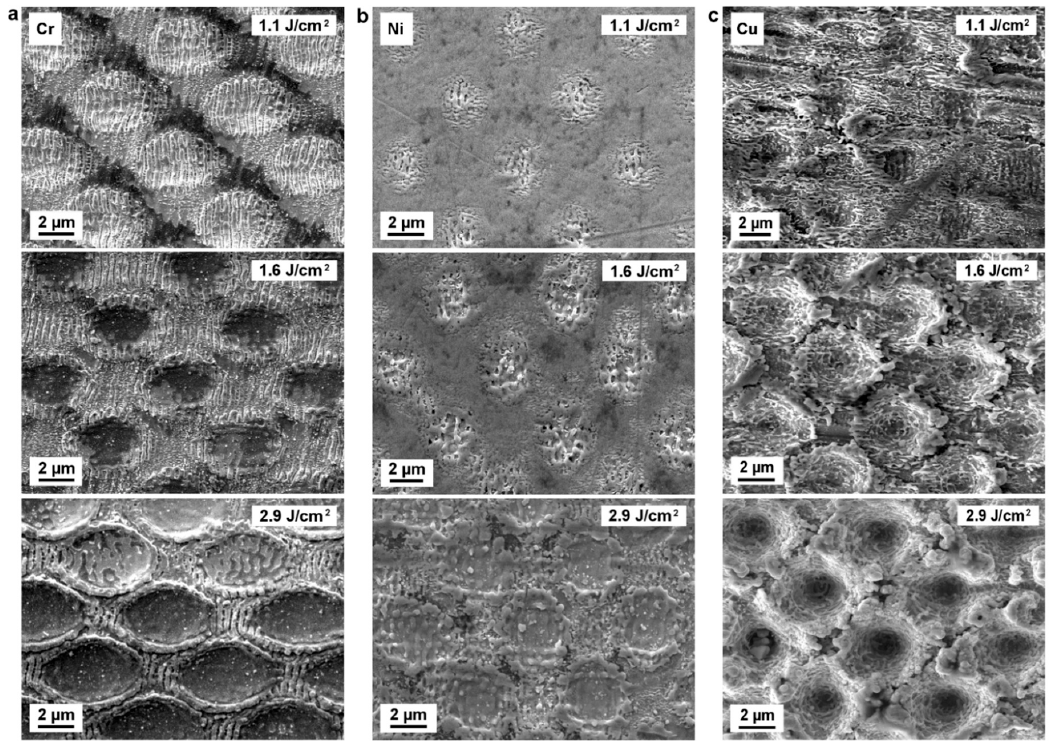
Figure 2. SEM images of ( a ) Cr, ( b ) Ni, and ( c ) Cu structured surfaces using DLIP with 10 (Cr, Ni) or 80 (Cu) laser pulses and different laser fluences of 1.1 J/cm 2 , 1.6 J/cm 2 , and 2.9 J/cm 2 .